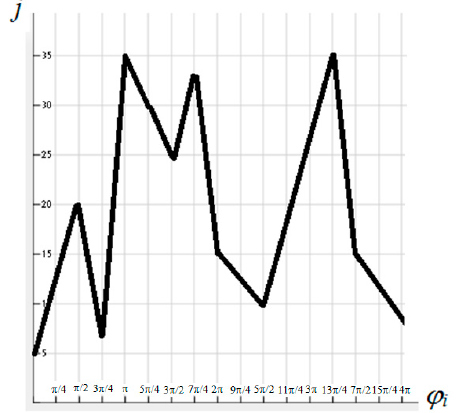
Figure 5. Graph Γ ( ϕ i , j ) of sequence ( ϕ i , j ) from DNA sequences.